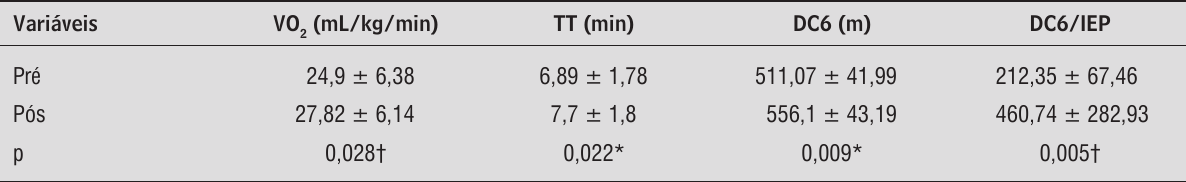
Legenda: mL/kg/min = mililitro de oxigênio por kilograma por minuto; m = metros; p < 0,05; * = teste t de Student pareado; † = teste de